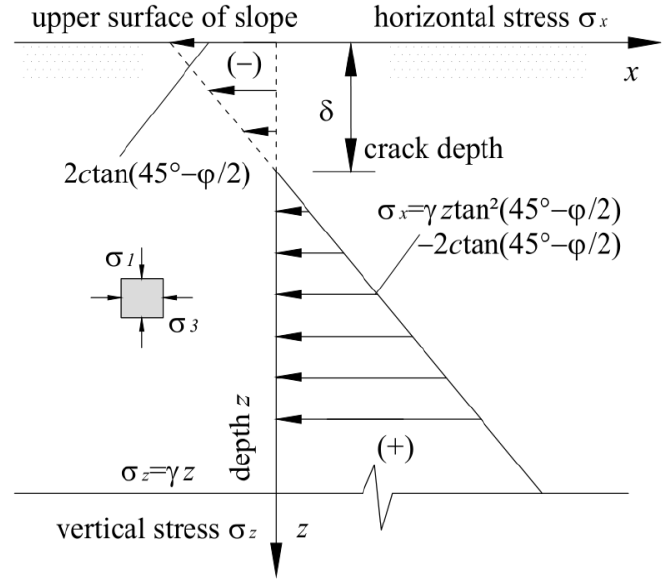
Figure 1. Stress distribution of soil.